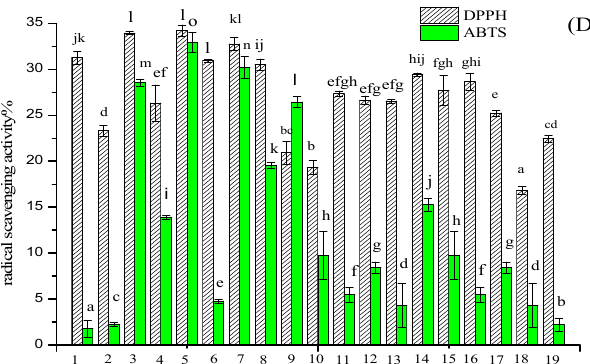
Figure 4. Reversed-phase chromatogram fraction П -2 and activities of each fraction: elution profile of fraction П -2 by ProntoSIL C18 ace-EPS column ( A ), DPPH and ABTS radical scavenging activities of 15 eluting fractions ( B ); elution profile of fraction П -2-6 by the analytical Cosmosil pbr column (Ø 4.6 × 250 mm, 5 μ m) ( C ), and DPPH and ABTS radical scavenging activities of 19 eluting fractions ( D ). different letters in the same test in ( B , D ) indicate significant differences ( p < 0.05).